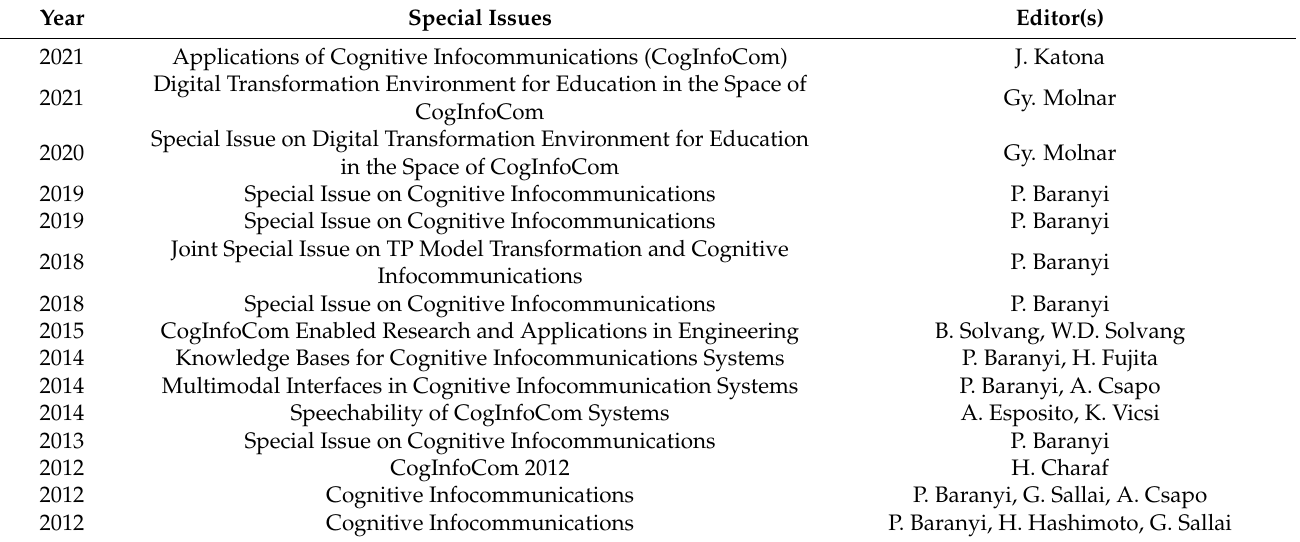
Table 1. Journal special issues related to CogInfoCom topics.